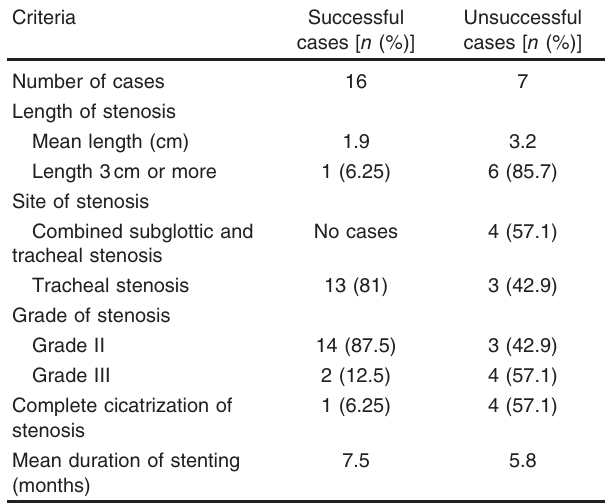
Flexible endoscopic view in a successful case three months after tracheal T tube removal.